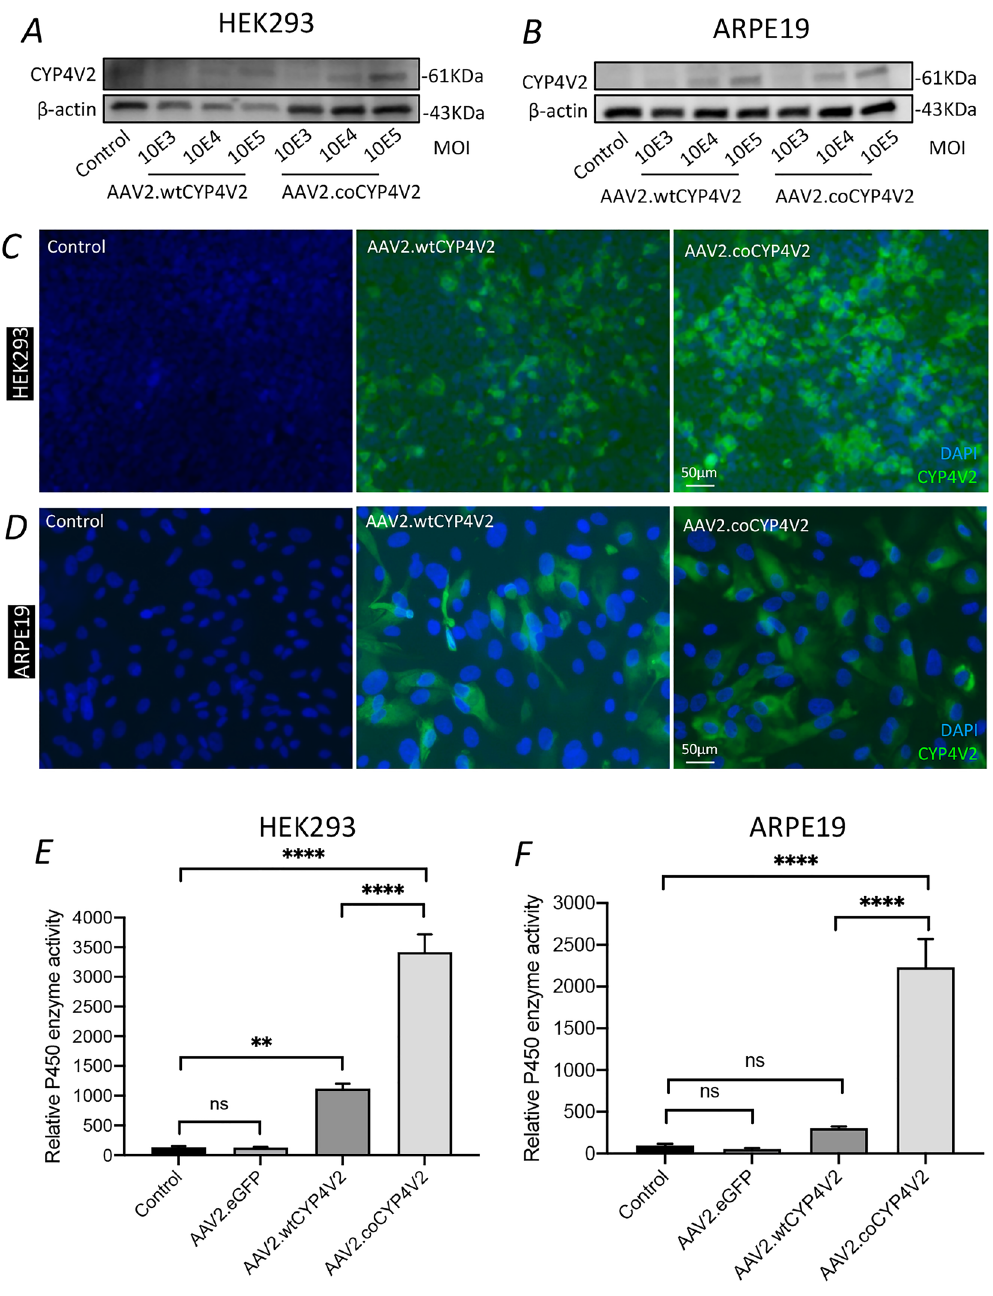
Figure 2. CYP4V2 expression following AAV2 transduction of cultured cells . ( A and B ) CYP4V2 expression in HEK293 and ARPE19 cells transduced with AAV2.wtCYP4V2 and AAV2.coCYP4V2, respectively, at multiplicities of infection (MOI) from 10E3 to 10E5, assessed by Western blot. ( C and D ) CYP4V2 expression in HEK293 and ARPE19 cells transduced with AAV2.wtCYP4V2 and AAV2.coCYP4V2, respectively at MOI of 10E5, assessed by immunocytochemistry. ( E and F ) CYP4V2 enzyme activity was quantified by Multi-CYP assay in HEK293 and ARPE19 cells transduced with AAV2.wtCYP4V2, AAV2.coCYP4V2 and control AAV2. eGFP. Mean ± SEM (n = 6). ** p < 0.01. **** p < 0.00001. ns, not